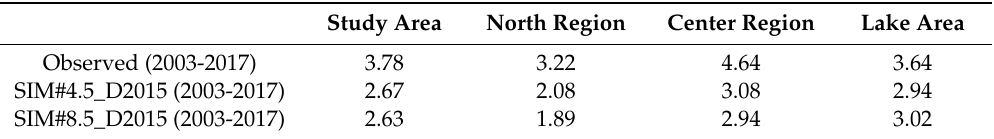
Figure 12. Estimates of mean annual soil erosion rates based on observations (left); and using erosion Table 6. Mean observed and simulated annual erosion rates [t ha − 1 yr − 1 ] with two climate scenarios and static land cover (DUSAF Table 6. Mean observed and simulated annual erosion rates [t ha -1 yr -1 ] with two climate scenarios and static land cover (DUSAF 2015).